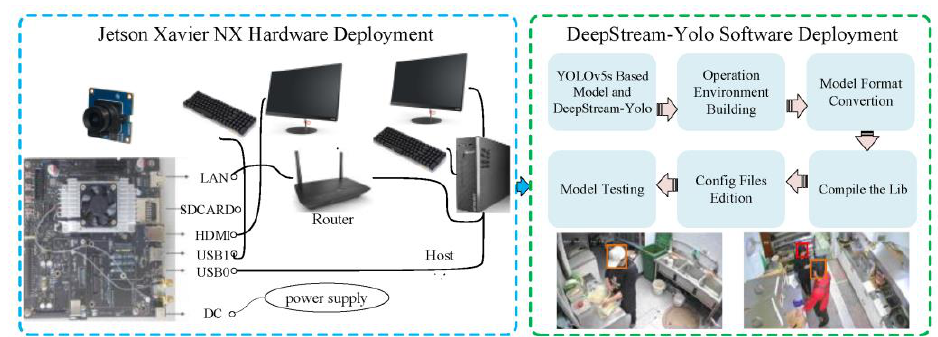
Figure 2. The process of deploying a detection model to Jetson Xavier